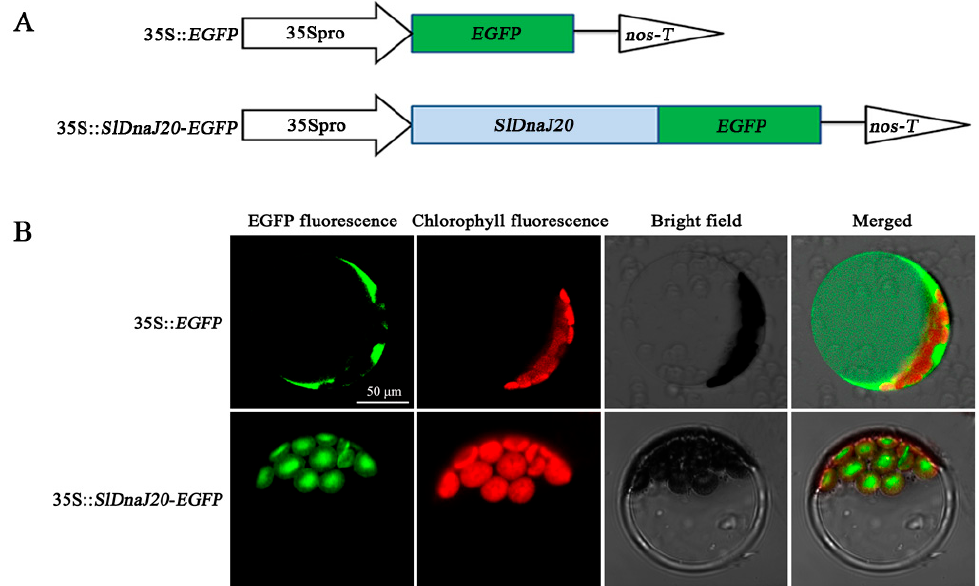
Figure 2. Subcellular localization of SlDnaJ20. ( A ) Pattern of enhanced GFP (EGFP) fusion protein structure. 35Spro, CaMV35S promoter. nos-T, nopaline synthase terminator. ( B ) 35S:: EGFP (upper panels) and 35S:: SlDnaJ20-EGFP (lower panels) were transiently expressed in Arabidopsis protoplast. Protoplasts were examined under laser confocal microscopy.